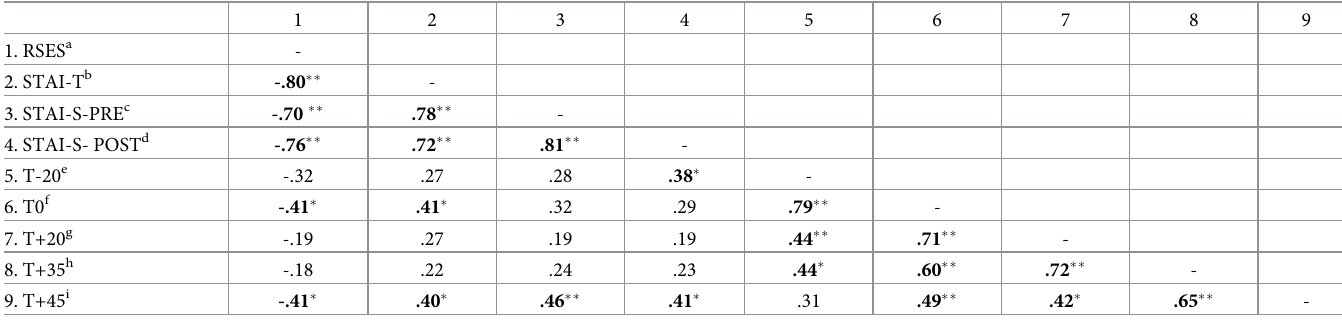
Table 4. Pearson coefficients for associations between RSES and state-trait anxiety and cortisol